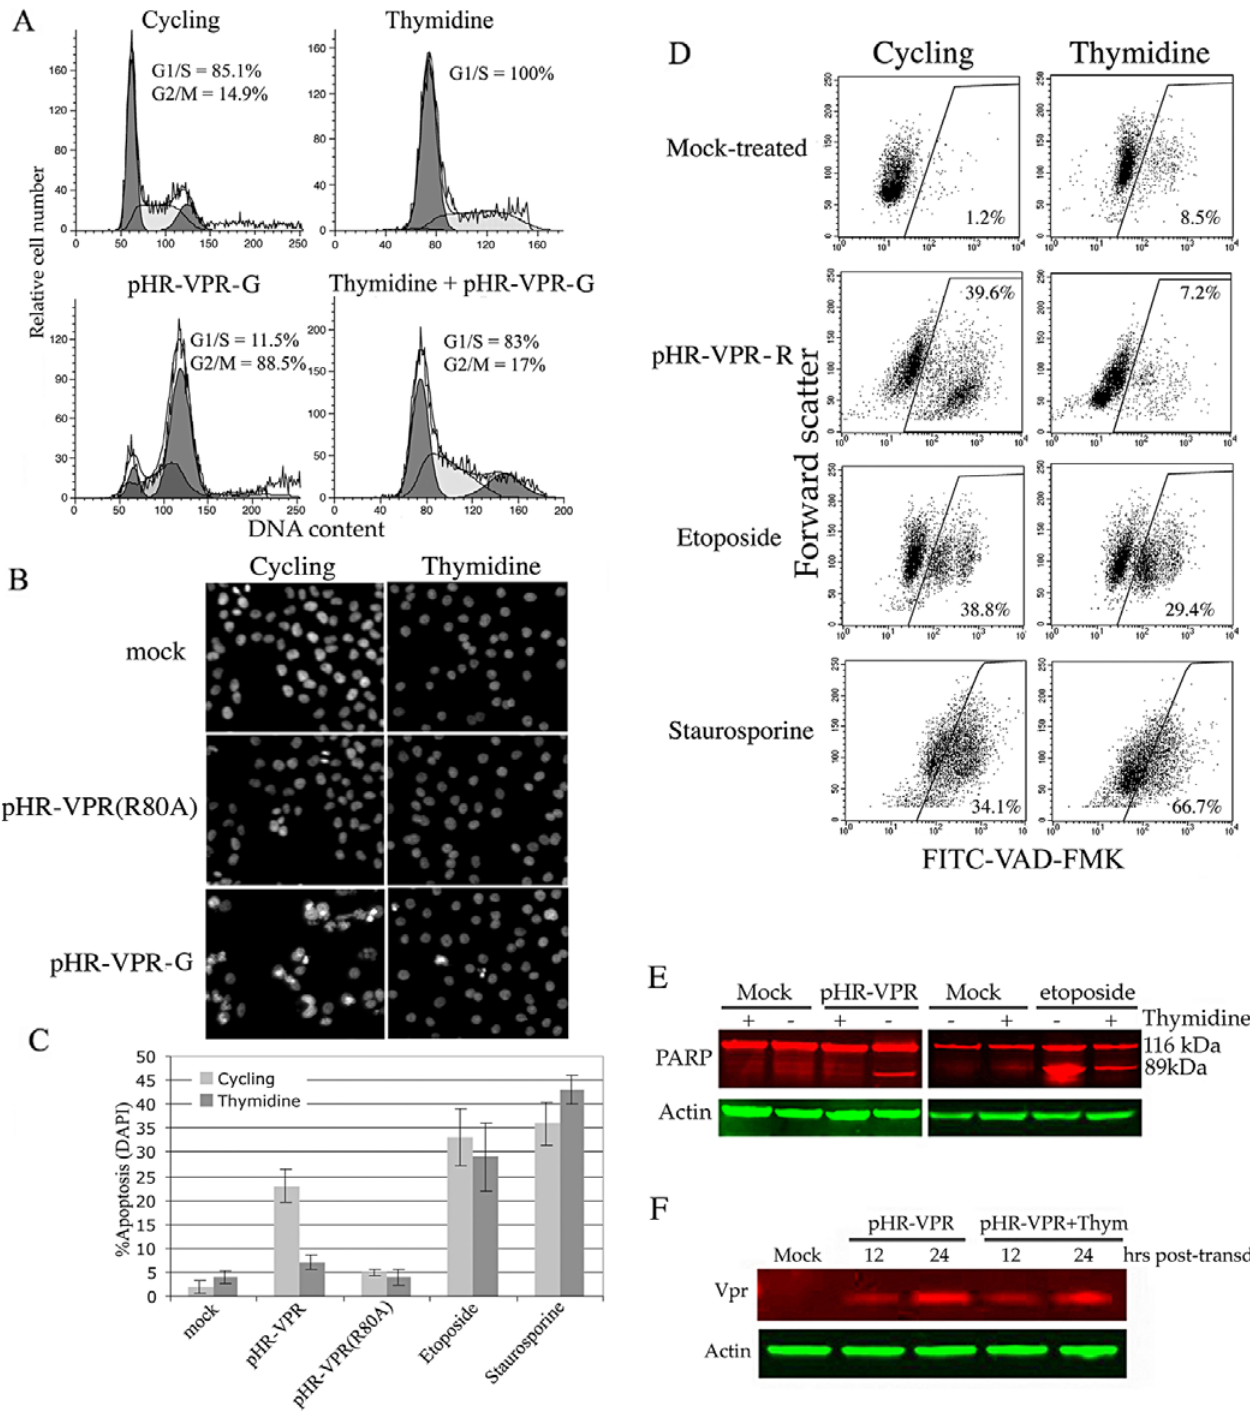
Figure 2. The Apoptotic Effect of Vpr Is Lost in Cells Synchronized in G 1 /S (A) HeLa cells were transduced with pHR-VPR-G or mock-transduced and then incubated with 2 mM thymidine. After 24 h of incubation, cells were harvested,stainedwithPI, andanalyzedforDNAcontentbyflowcytometryto determinethepercentageofcellsinG 1 /SandG 2 /M.Transductionefficiency ofpHR-VPRinboththymidine-treatedandcyclingcellswas70%to75%asdeterminedbyanalysisofGFPexpressionbyflowcytometry(unpublisheddata). (B) Cells from experiments shown in (A) were stained for DAPI at 72 h postinfection, in order to evaluate apoptosis via chromatin morphology (C) Quantitation of apoptosis in DAPI-stained samples shown in (B); incubation with 25 l M etoposide for 48 h or 1 l M staurosporine for 8 h was included in both cycling and thymidine-treated cells, for comparative purposes. (D) Cycling or thymidine-synchronized HeLa cells were mock-transduced or transduced with either pHR-VPR-R or pHR-VPR(R80A) for apoptosis analysis, using FITC-VAD-FMK. As positive controls for apoptosis, cycling and synchronized cells were treated with etoposide or staurosporine as shown in (C). (E) Cycling or thymidine-synchronized HeLa cells expressing Vpr or treated with 25 l M etoposide for 48 h were lysed and analyzed by Western blot for PARP cleavage as a marker of apoptosis/caspase activity. The caspase-cleaved PARP band is observed at 89 kDa. (F) Cell lysates from pHR-VPR–transduced cells, with or without thymidine block, were harvested at 12 and 24 h post-transduction and analyzed by Western blot for Vpr expression with antibodies specific to the amino-terminal hemagglutinin tag. doi:10.1371/journal.ppat.0020127.g002 PLoS Pathogens |